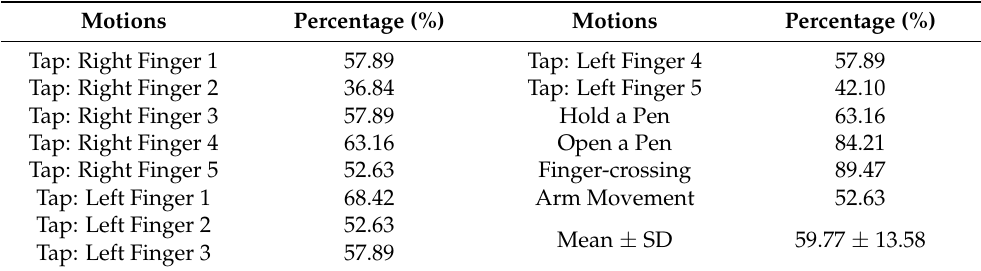
Table 4. Percentage of “follow-up” pattern in motions at Cz among all subjects.